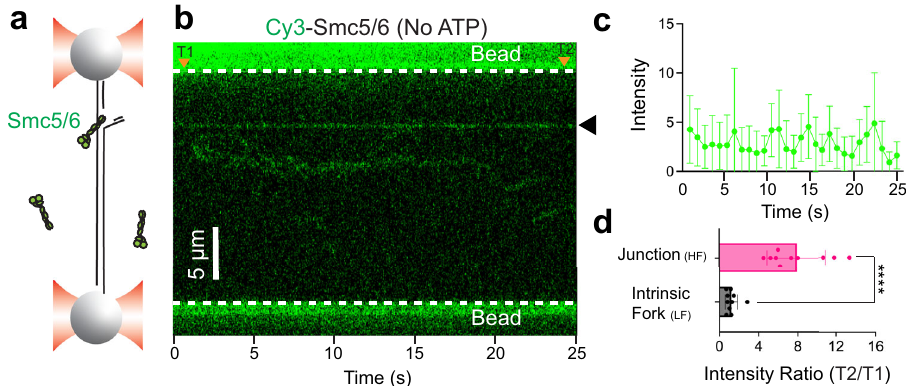
deviation. d Smc5/6 fl uorescence intensity ratio between two timepoints (T1 and T2 as indicated by orange arrows in panel b ) at an intrinsic fork under LF versus at a DNA junction generated at HF. Bar heights indicate the group mean and error bars represent standard deviation. P value was determined from a two-tailed unpaired t -test with Welch ’ s correction (**** P < 0.0001). The sample sizes are: Junction HF ( n =10) and Intrinsic Fork LF ( n = 10), where n indicates the number of Smc5/6 streaks analyzed. Source data for panels c and d are provided within the Source Data fi